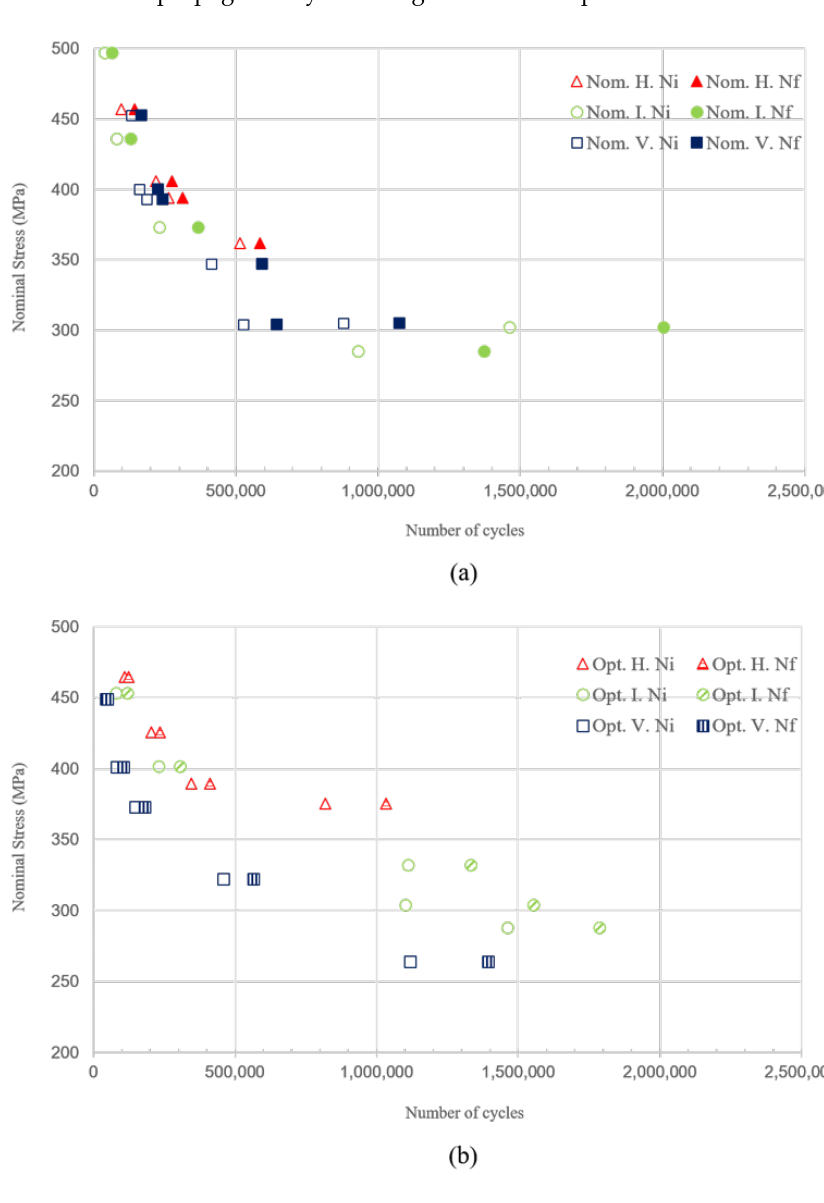
Figure 10. Nucleation phase and propagation and final failure phase of the specimens built with ( a ): nominal parameters and ( b ): optimized parameters. N i is the number of cycles at the end of the nucleation phase and N f is the number of cycles at the final failure of the